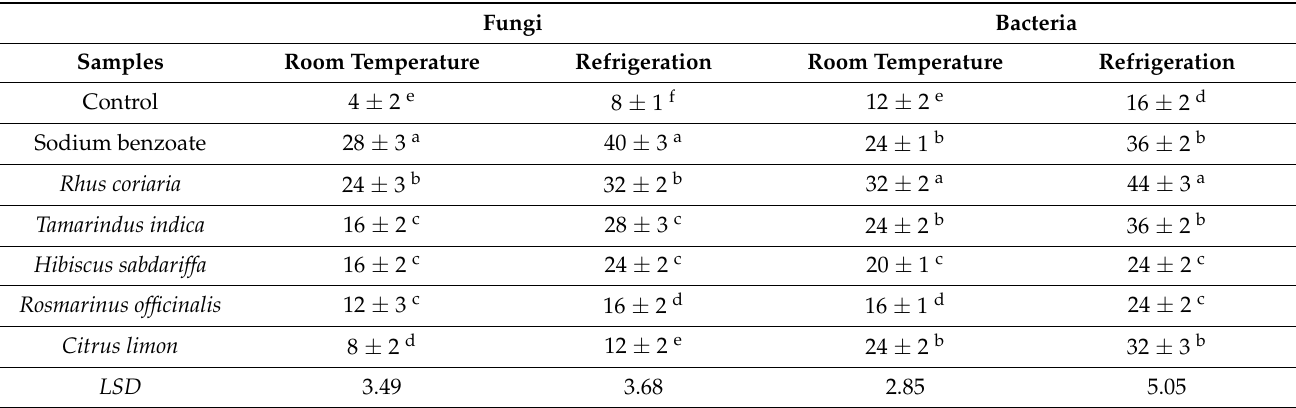
Table 6. Days required for appearance of microbial growth in the homemade tomato paste samples under different storage